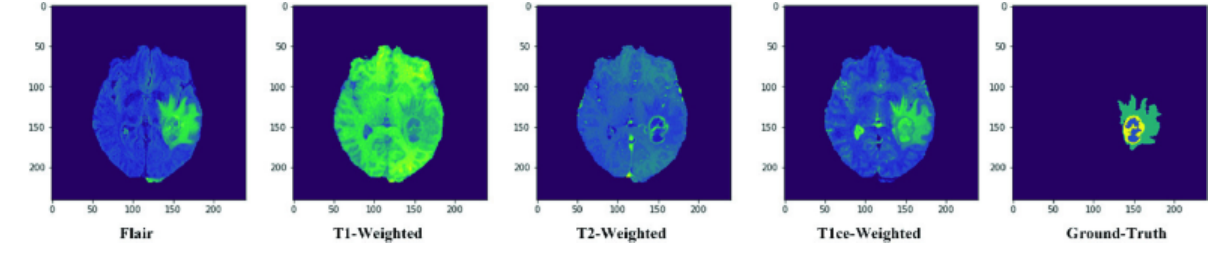
Figure 3. Dataset Samples from